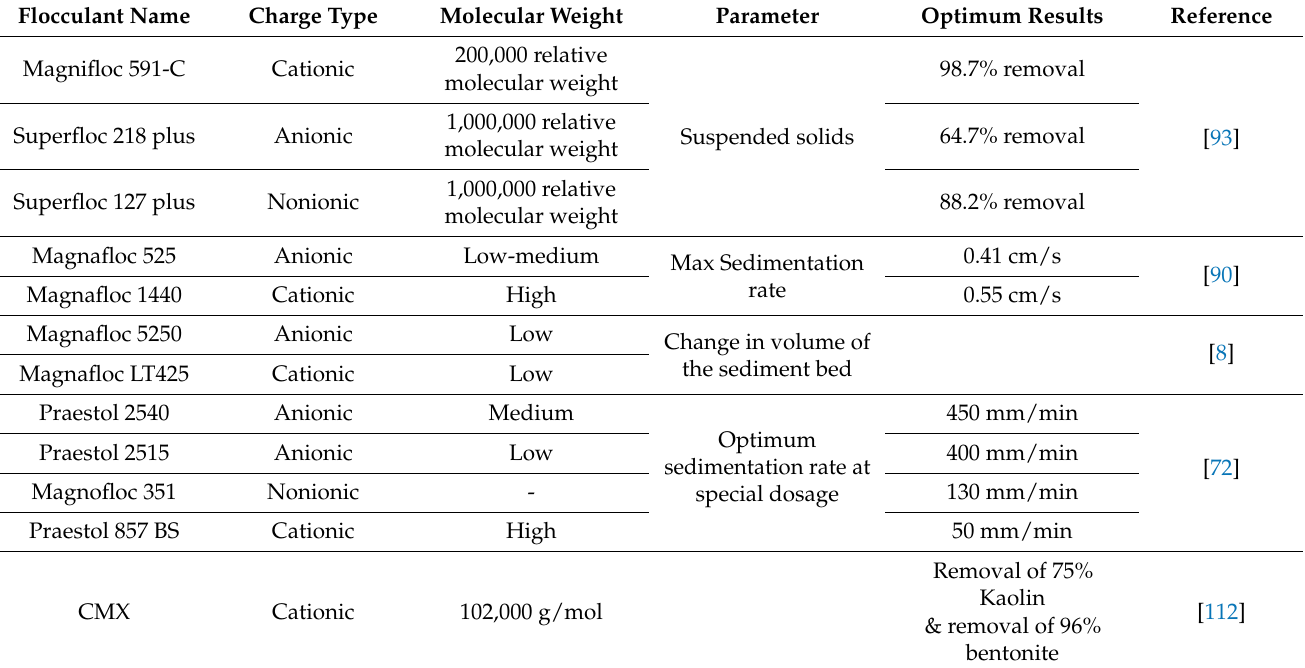
Table 4. Application of single and dual polymeric flocculants for coal slurry components